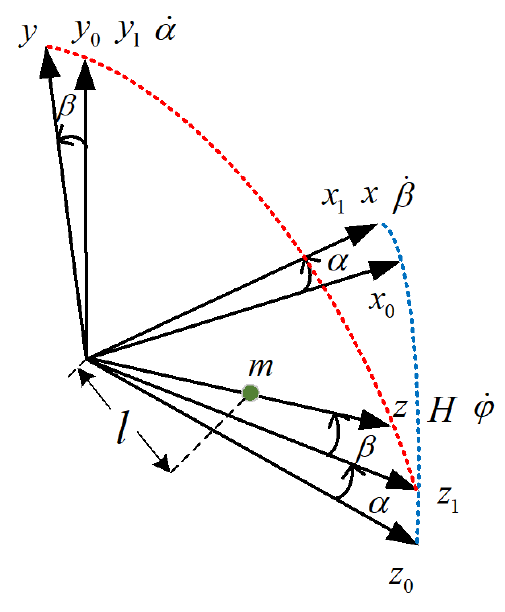
Figure 1. Internal coordinate system of